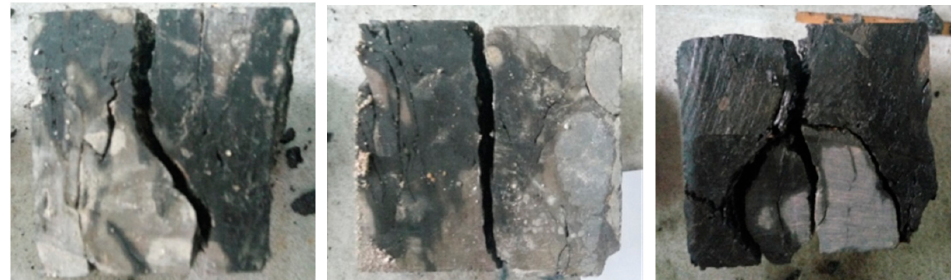
Figure 2. Typical failure modes of oil shale specimen (50 × 50 × 50 mm) containing the concretions after test.